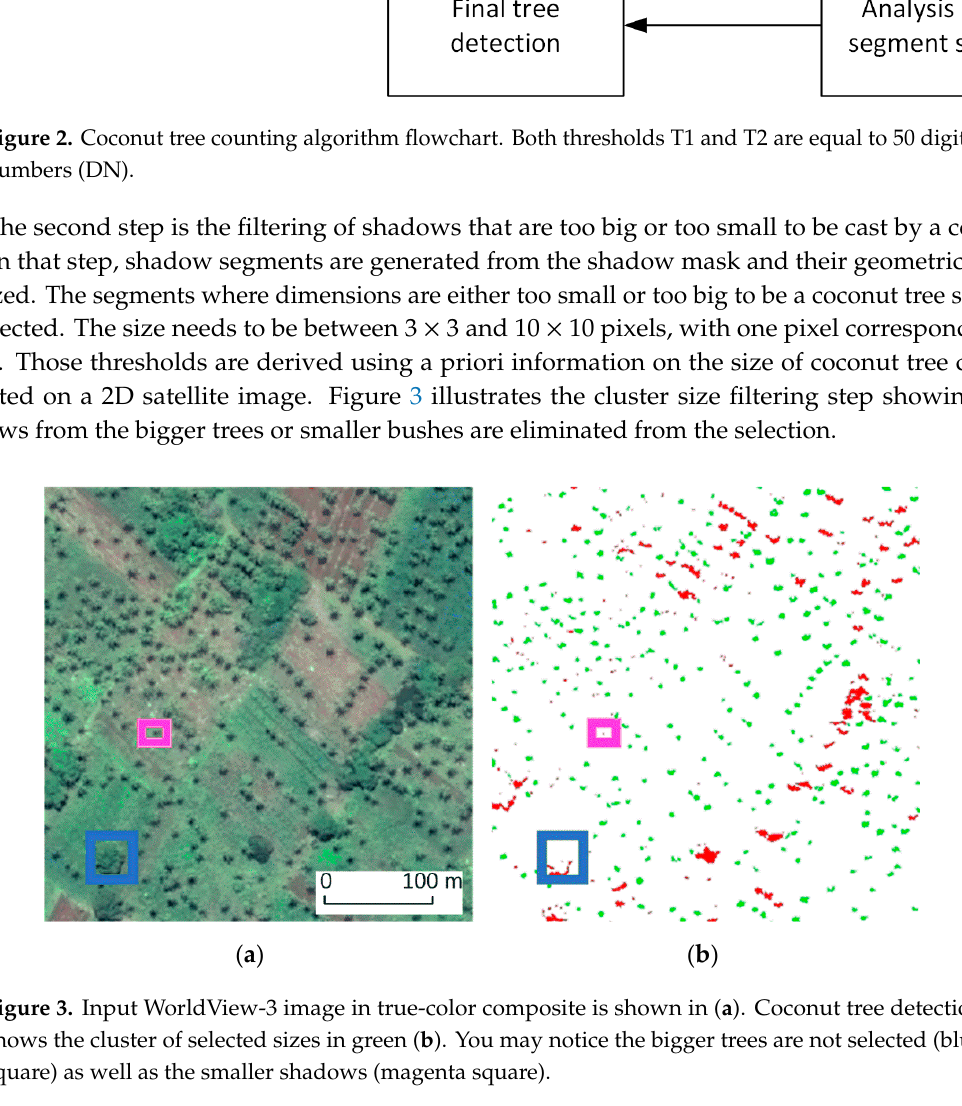
Figure 2. Coconut tree counting algorithm flowchart. Both thresholds T1 and T2 are equal to 50 digital numbers (DN).